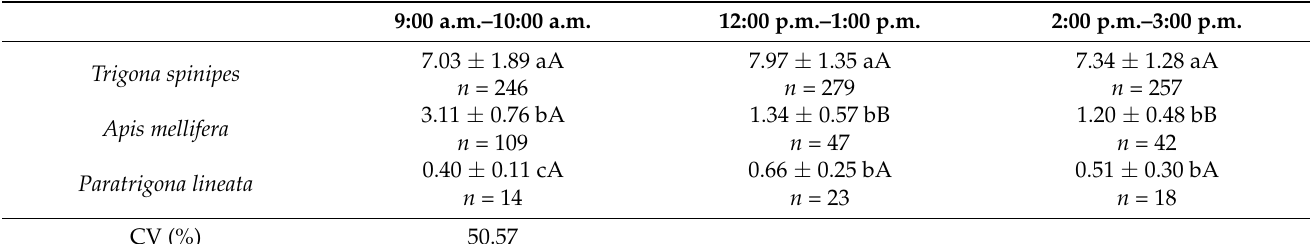
Table 2. Abundance of visiting bee species in Tropaeolum majus flowers at different day